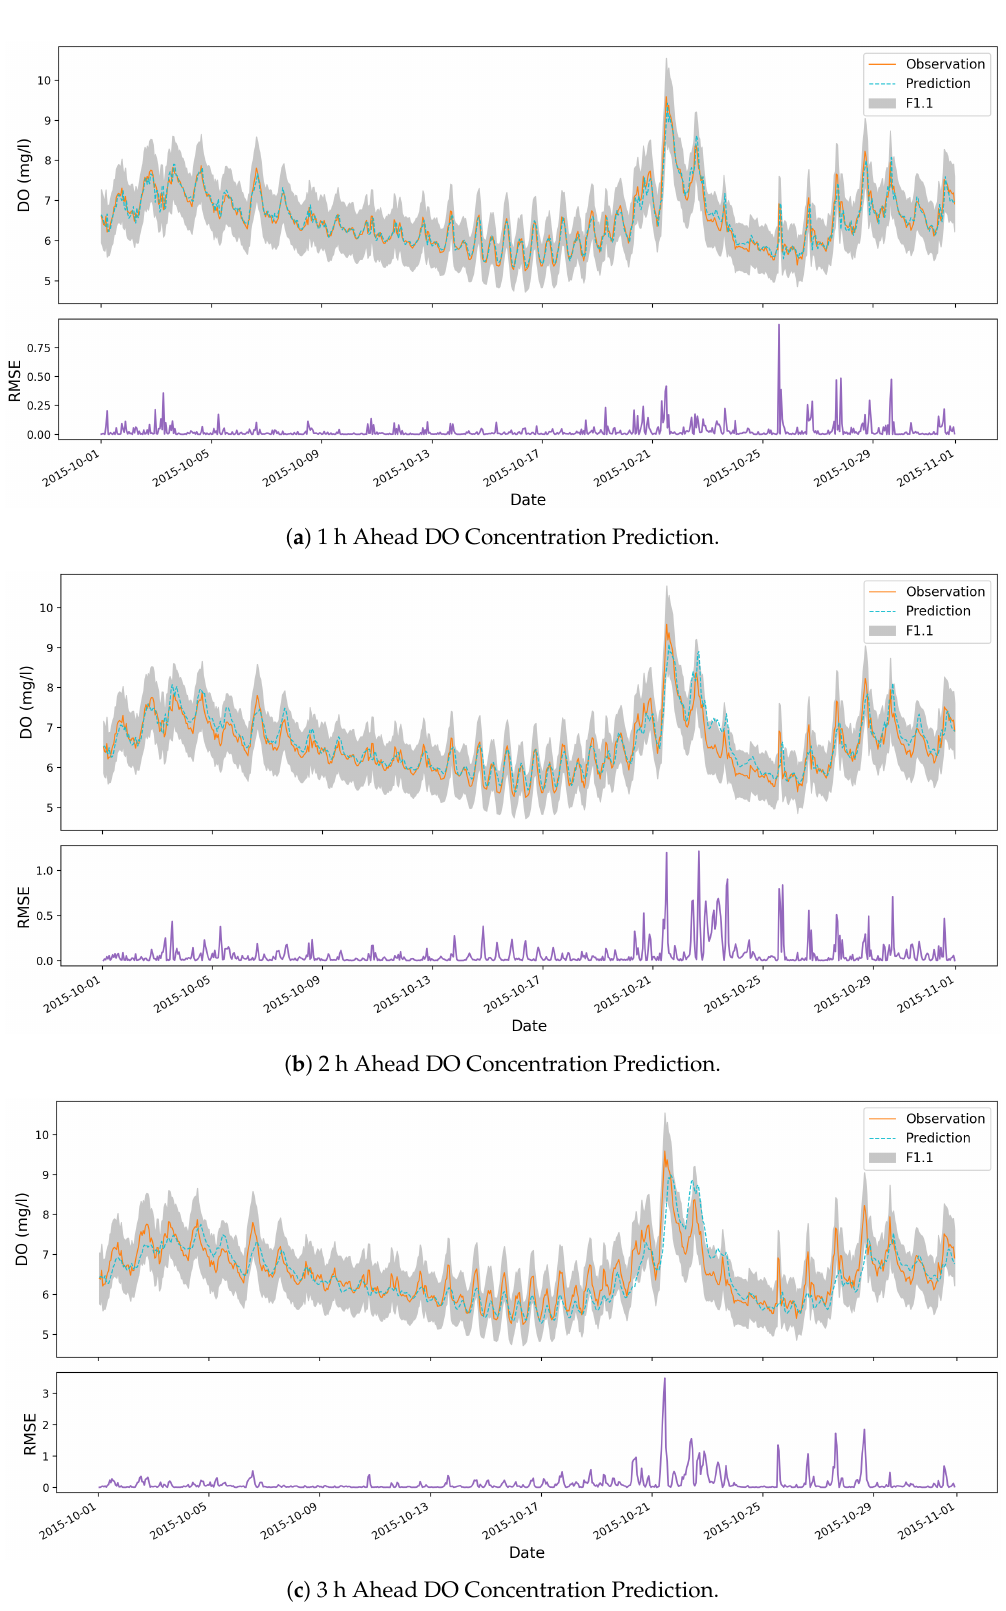
Figure 8. 1, 2 and 3 h ahead predicting for the concentration of DO. In the upper part of each subfigure, the grey shadow, solid line and dotted line represent the FA1.1 range, DO observations and predictions, respectively. The lower part of each subfigure describes the RMSE value at each time